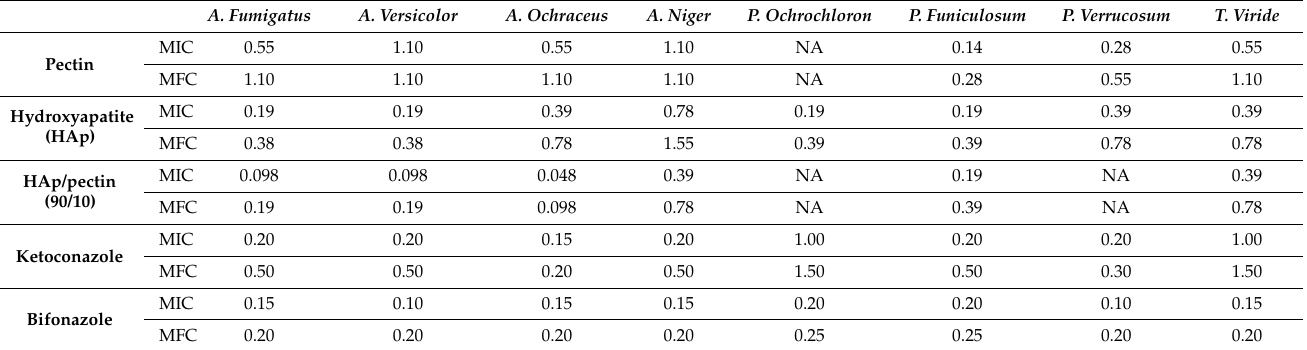
Table 4. Antifungal activity of Opuntia ficus-indica pectin, hydroxyapatite, and composites (HAp/pectin) in